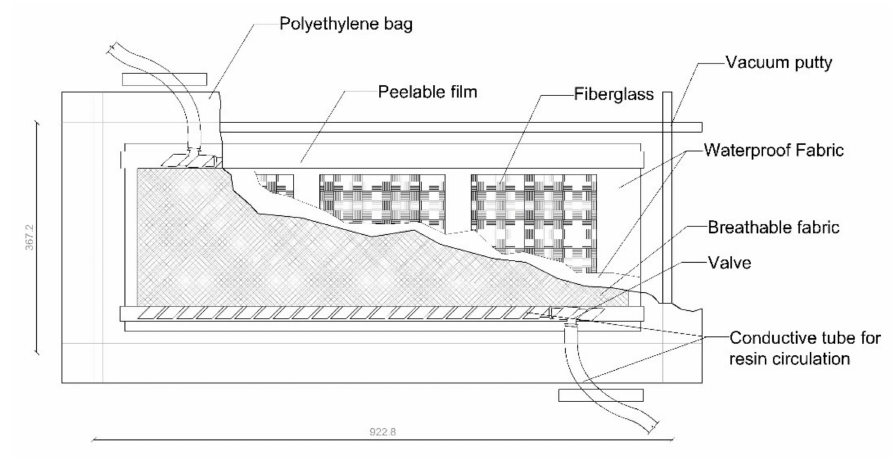
Figure 1. Vacuum bag for the manufacture of GFRP panels by vacuum resin infusion.